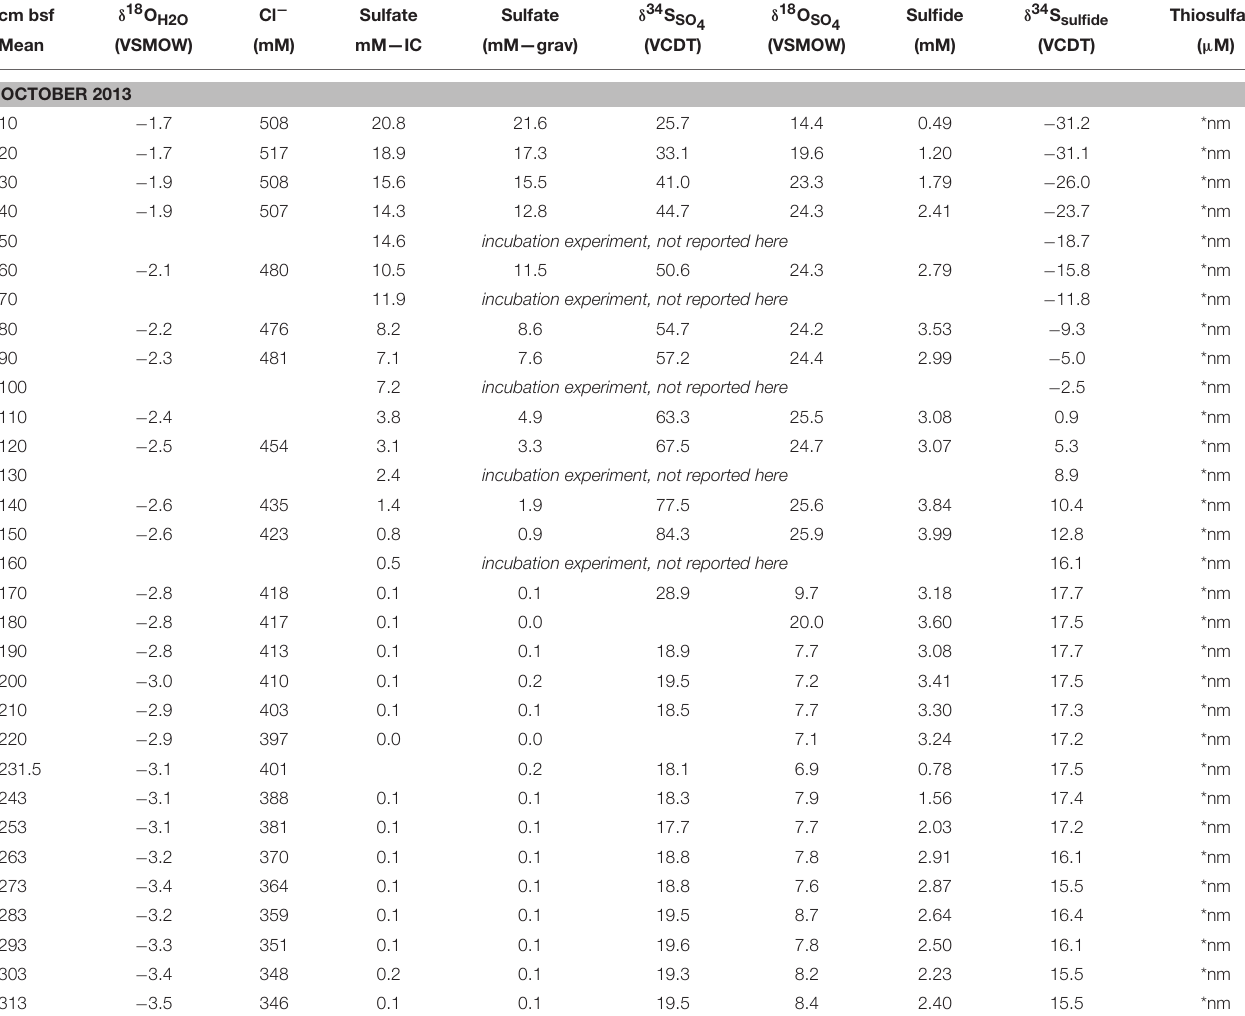
TABLE 3 | Concentration and isotope data for the Fall